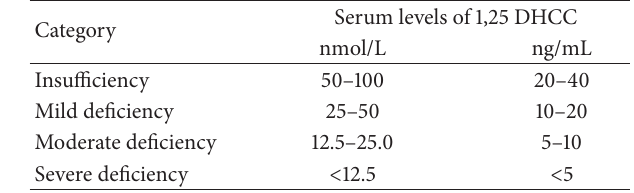
Table1:DefiningvitaminDstatusbasedonserum1,25DHCClevels Table 2: Categories of vitamin D deficiency [5].